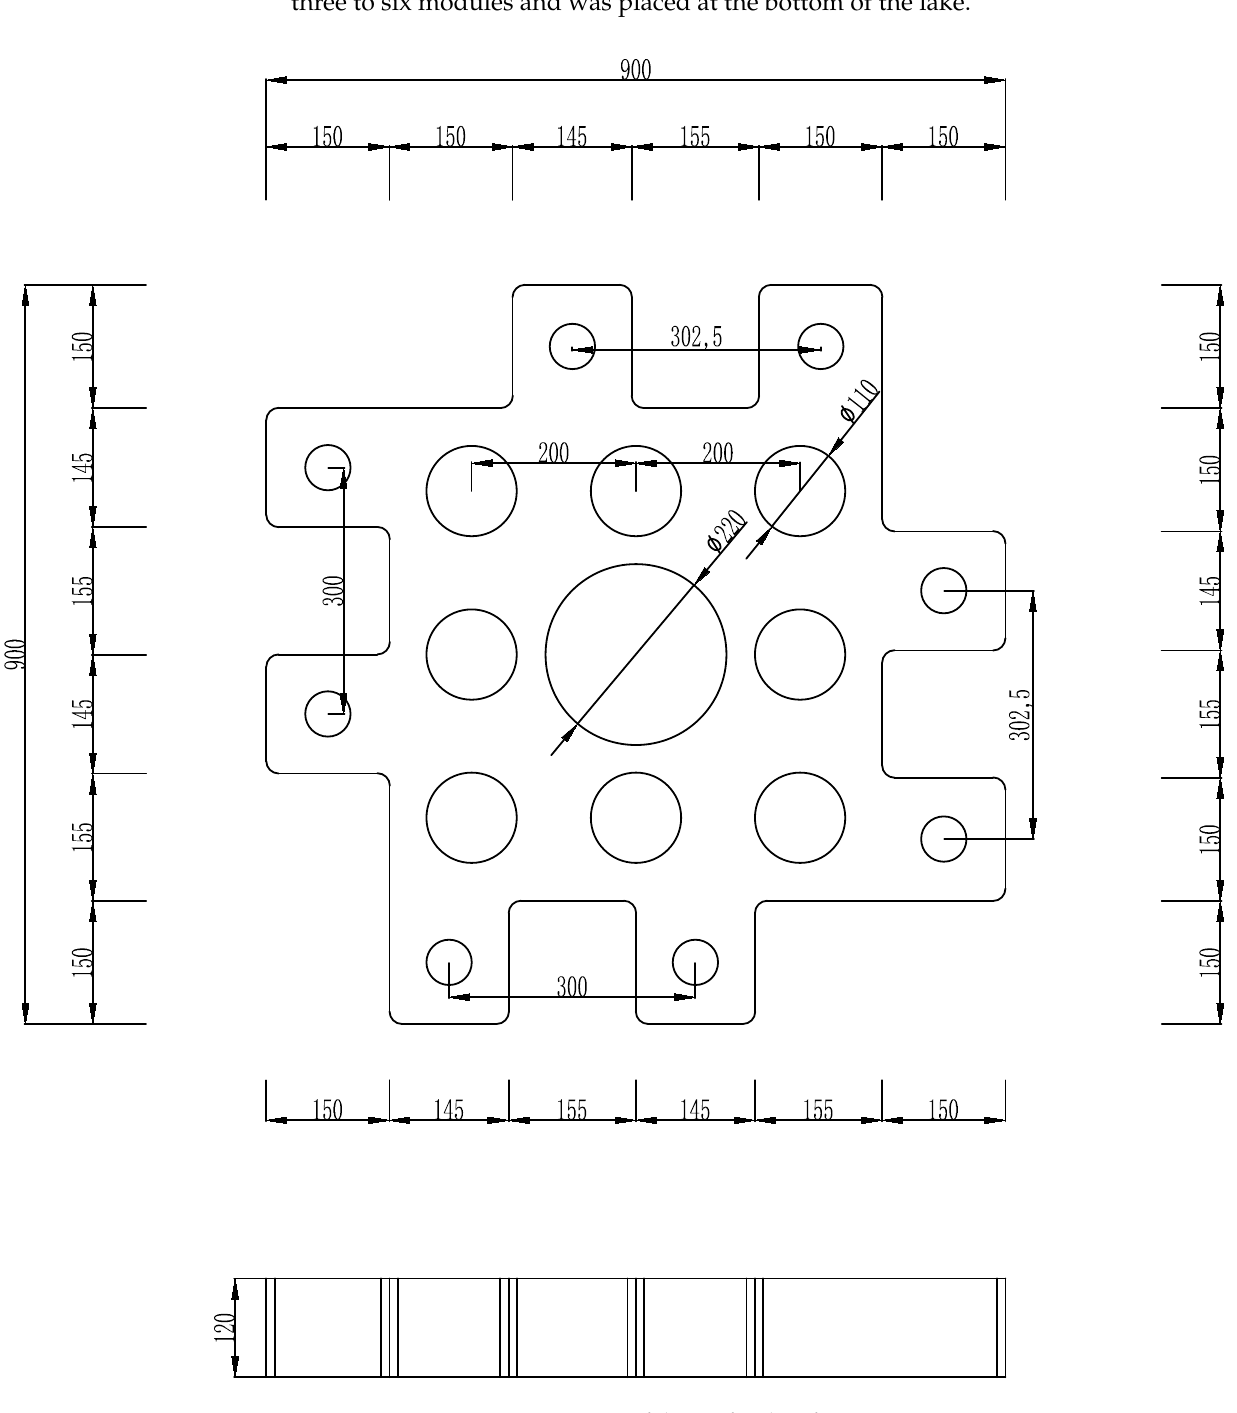
Figure 2. Dimensions of the artificial